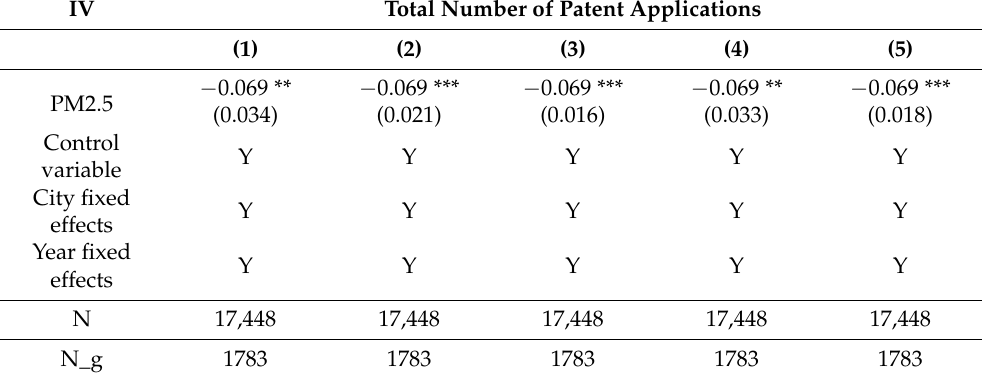
Table 8. Robustness test